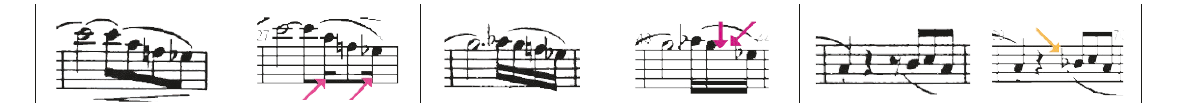
Figure 1: Examples of recognition errors provided by a commercial software [4] . On the left-hand side of each column, the original bar, on the right-hand side, the recognition